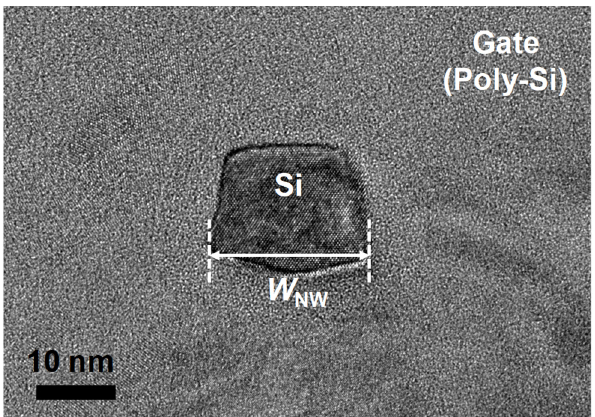
Figure 1. Transmission electron microscopy (TEM) image of the fabricated GAA FET.